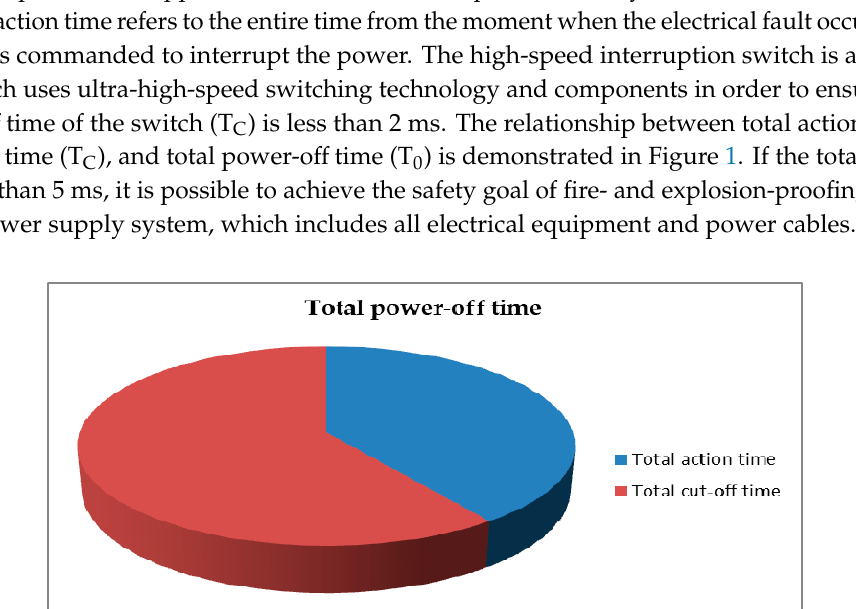
Figure 1. Power-off times.